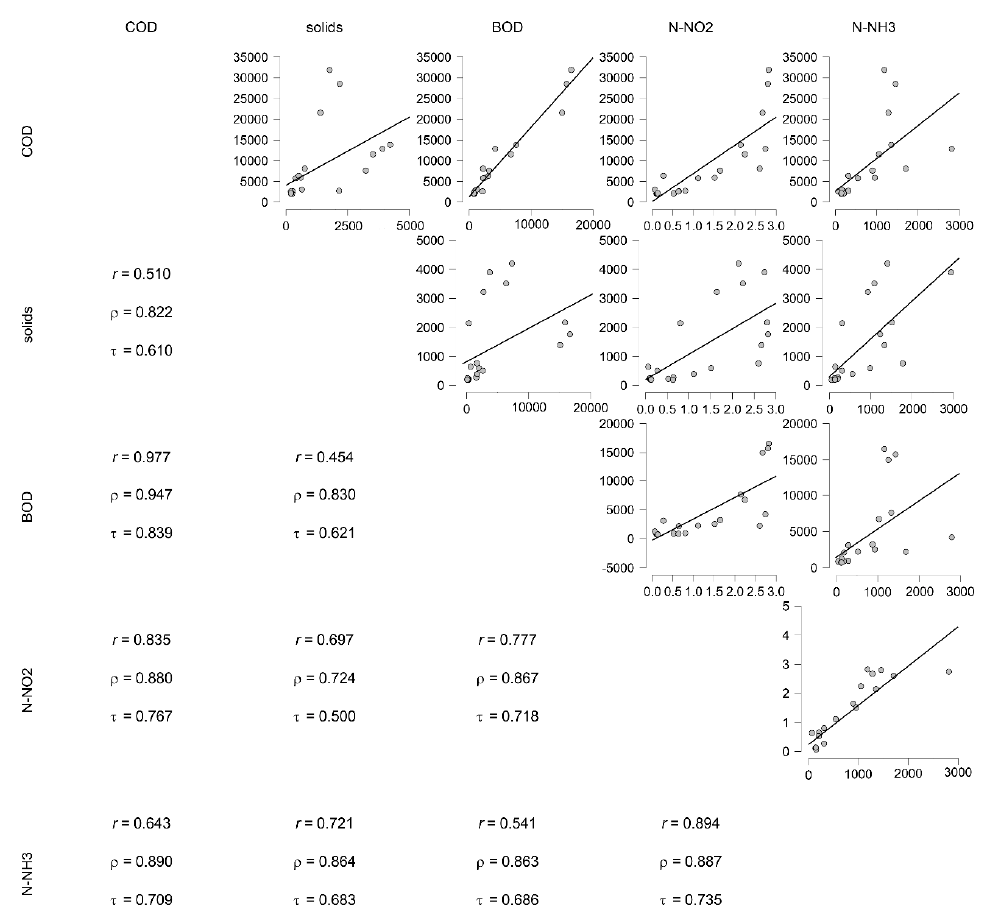
Figure 2. Correlation plot of technological wastewater components, with Pearson’s r, Spearman’s rho and Kendall Tau B coefficients.